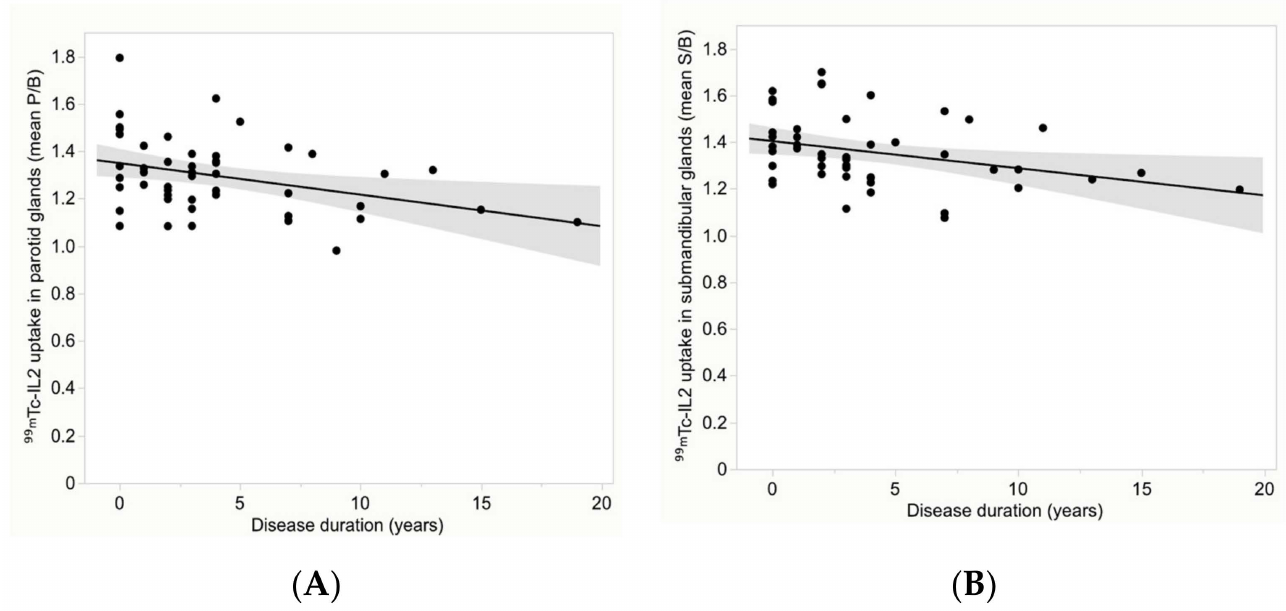
Figure 5. Distribution of the mean 99m Tc-IL2 uptake (P/B) in the parotid glands ( A ) and (S/B) in the submandibular glands ( B ) over the disease duration. A significant inverse correlation can be observed in all glands (correlation coefficient is − 0.22 ( p = 0.03) for the parotids and − 0.29 ( p = 0.006) for the submandibular